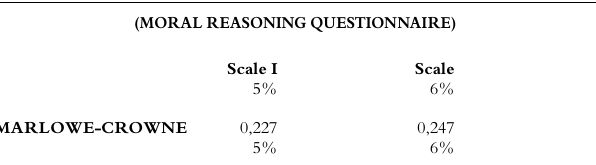
TABLE10 CORRELATIONSOF THE MARLOWE-CROWNESOCIALDESIRABILITY SCALEWITH SCALES I ANDII OF THE